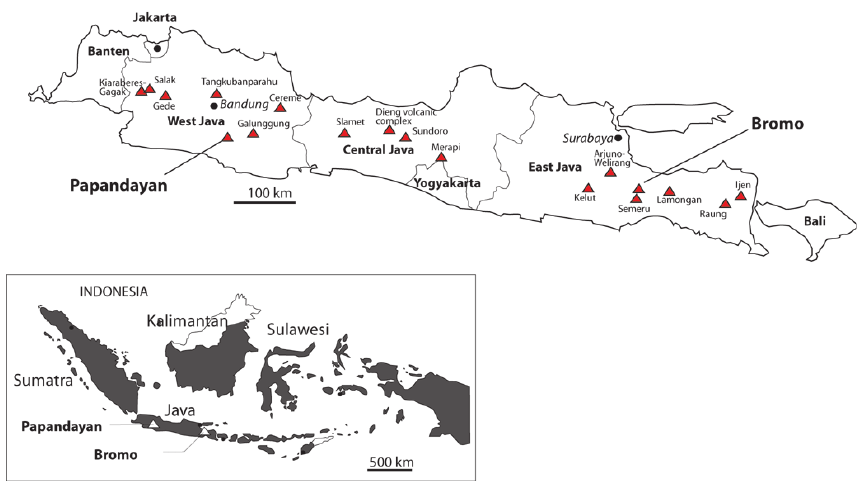
Fig. 1. Java island with its 18 active volcanoes. The target volcanoes, Papandayan and Bromo, are indicated. The location of Java and the studied volcanoes within the Indonesian archipelago is provided